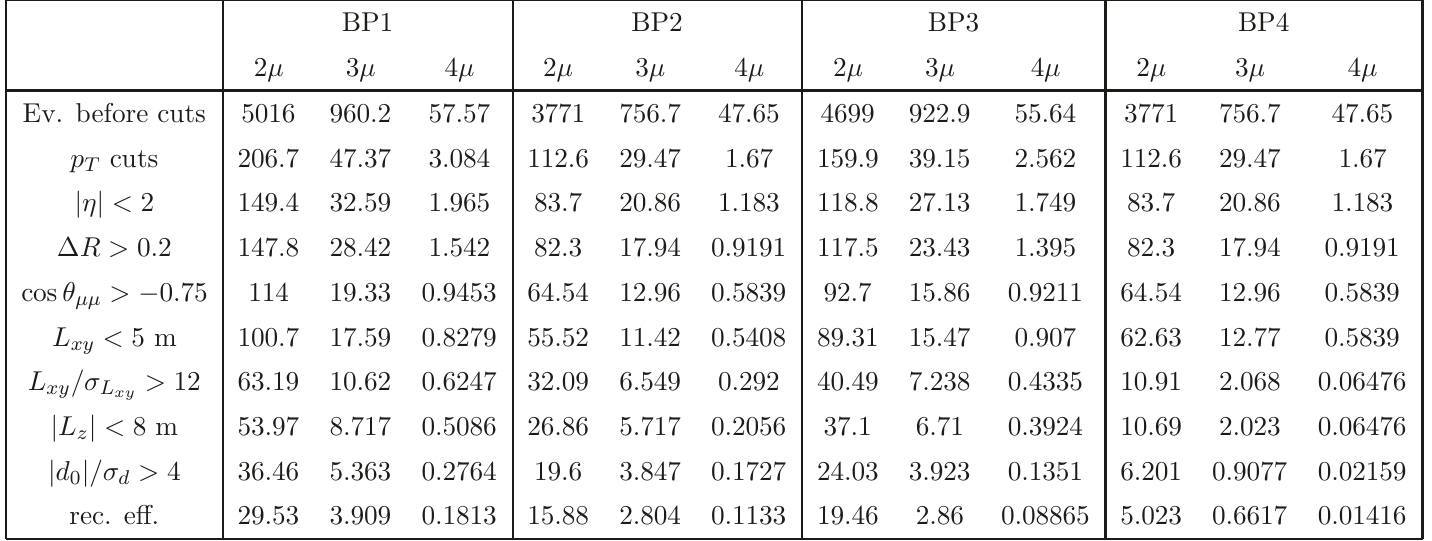
Table 4. Displaced muons in the muon chambers originated from heavy neutrinos produced by the SM-like Higgs. For each BP the initial number of events generated is the cross section σ ( pp H 1 ν h ν h ) multiplied by a luminosity of 100 fb − 1 . The p T cuts are applied in the following way: → → p T > 26 GeV for the two most energetic muons and p T > 5 GeV for all the others. The reconstruction efficiency of the muons has taken into